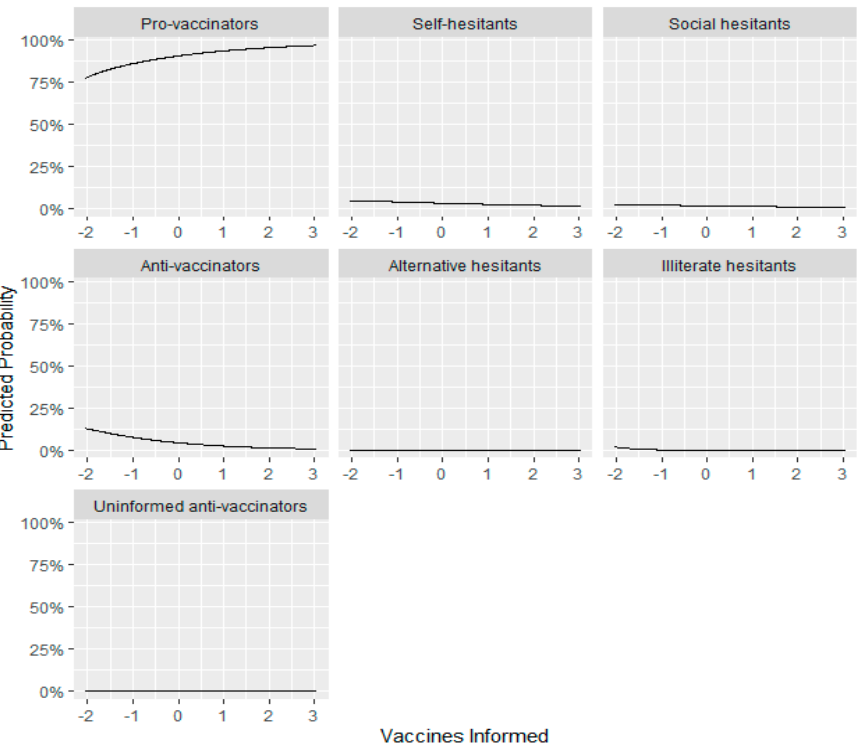
Figure A3. Marginal Effects Multinomial Logistic Regression. Vaccines Informed.